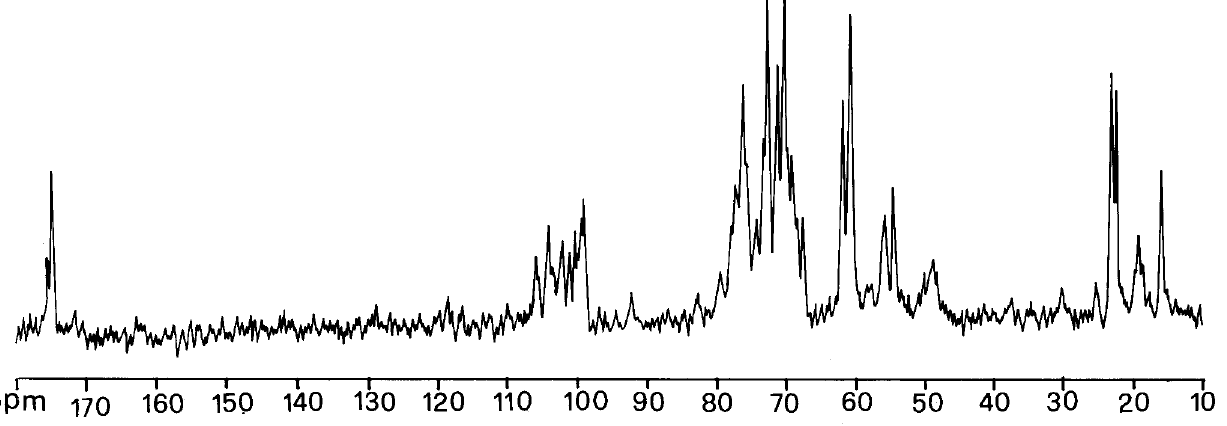
Fig. 3. 13 C-NMR spectrum of SM1 in D